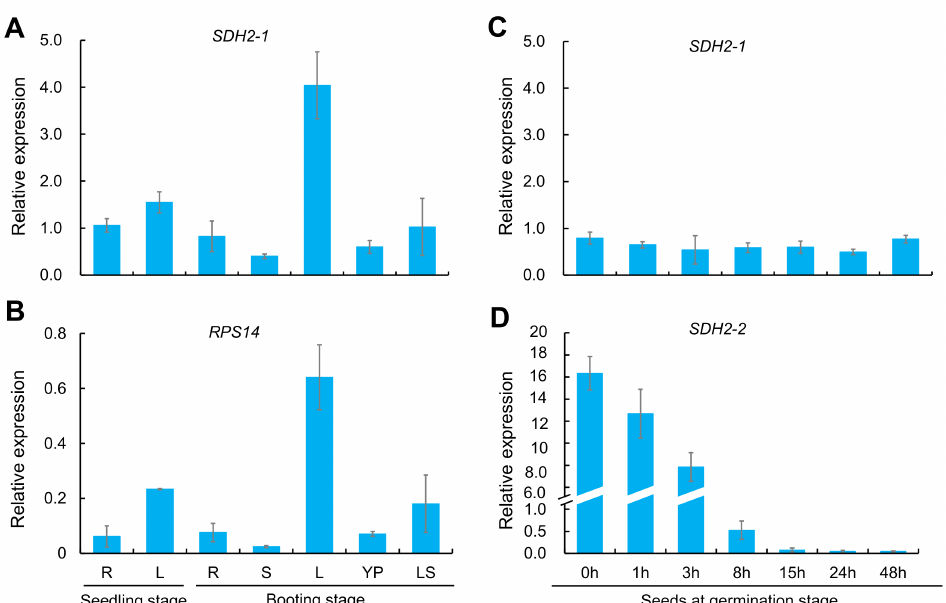
Figure 11. Spatio-temporal expression pattern of OsSDH2-1 , RPS14 and OsSDH2-2 in the wild type. ( A , B ) Expression pattern comparison between OsSDH2-1 and RPS14 in young and adult plants. R: root, S: stem, L: leaf blade, YP: young panicle, and LS: leaf sheath. ( C , D ) Expression pattern comparison between OsSDH2-1 and OsSDH2-2 in seeds at germination stage, respectively. Actin 1 was examined as the internal control. Error bars represent standard deviations of three independent biological